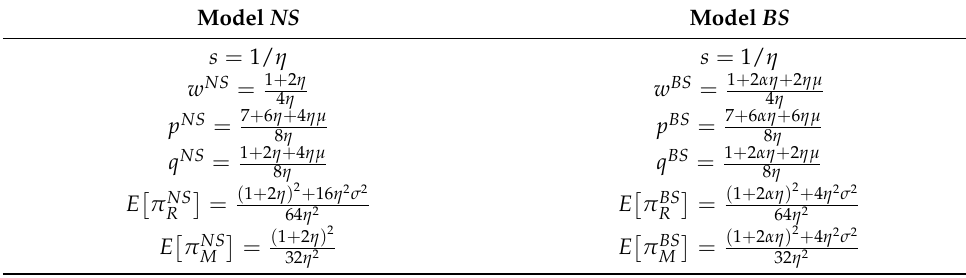
Table 3. Outcomes in Model iS ( i = N , B ) .